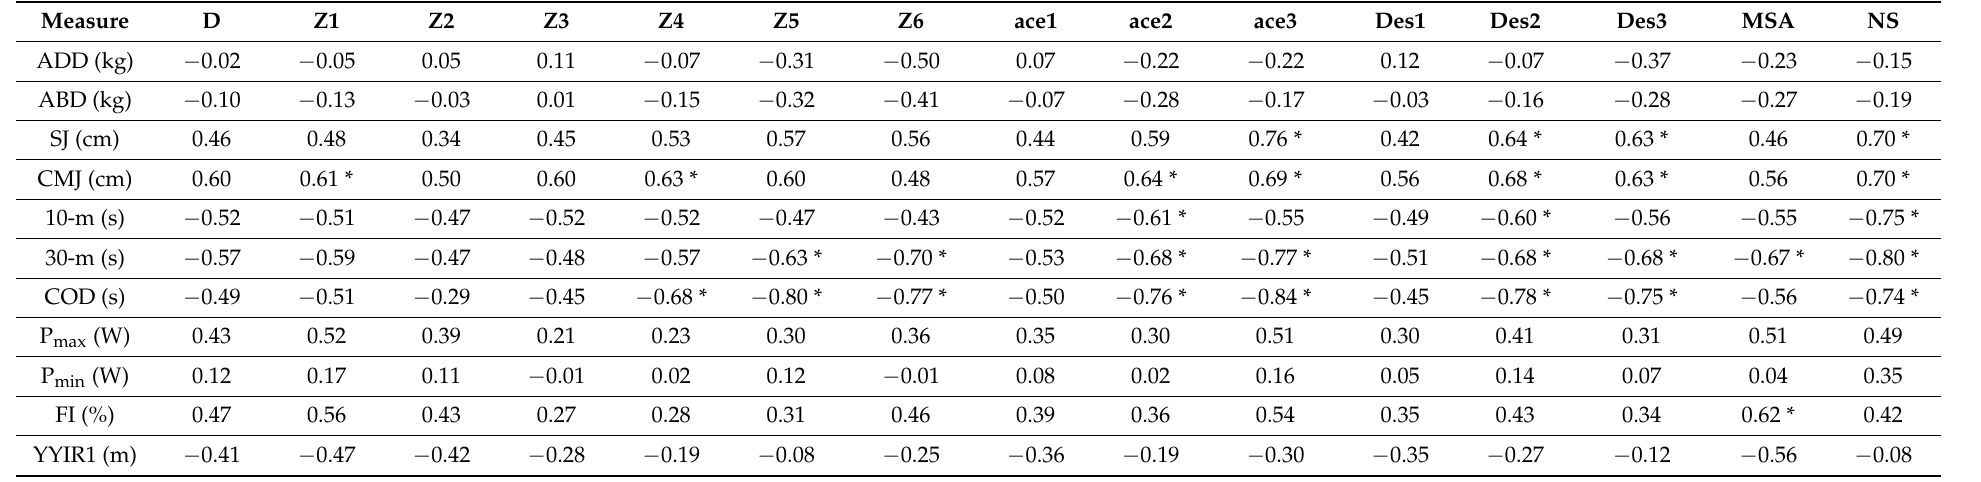
Table 4. Correlations between fitness status and match running (assessment 3 and matches 7 to